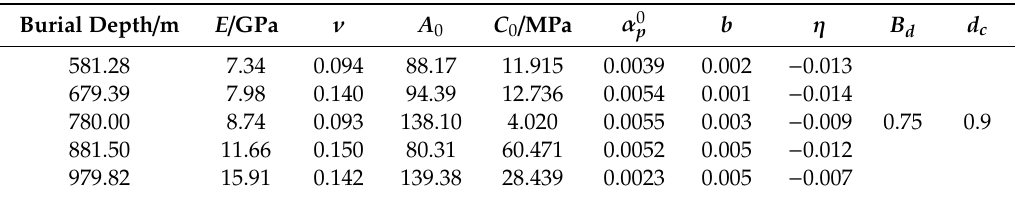
Table 1. Parameters of the constitutive model.